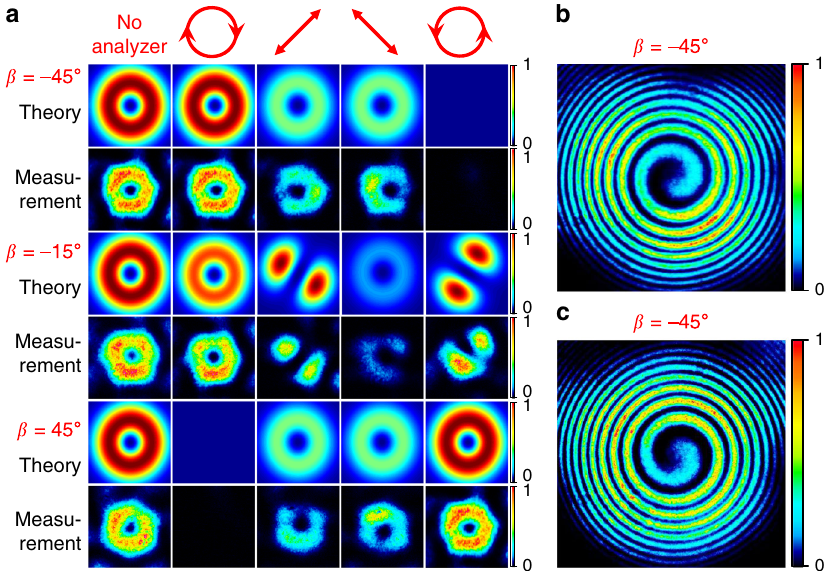
Fig. 6 OAM beams. a Theoretical (odd rows) and experimentally measured (even rows) output beams and the corresponding intensity pro fi les after passing through a rotated circular polarizer in the case of β = ±45° and β = − 15°. b The measured spiral interference fringes of the generated vortex beams with opposite handedness when β =